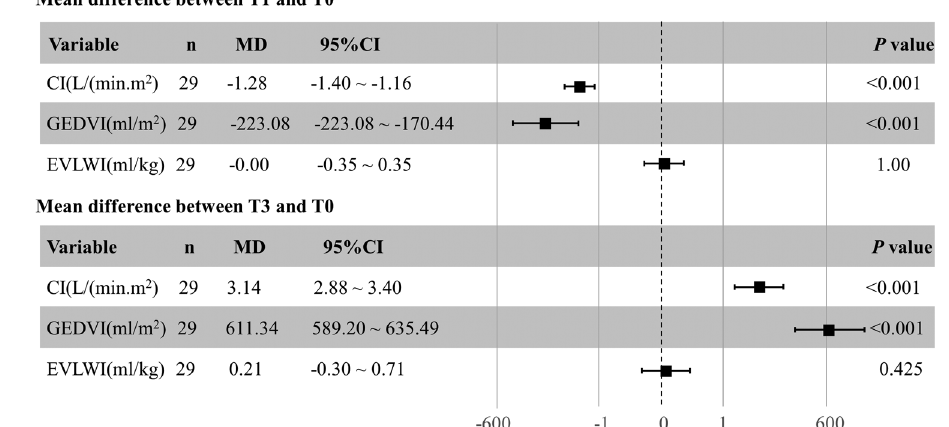
Figure 2: PICCO parameters changed at T1 and T3 when compared to baseline measurements ( T0 ) from 29 datasets obtained from 15 patients. MD: mean di ff erence; 95% CI: con fi dence interval; CI: cardiac index; GEDVI: global end - diastolic volume index; CRRT: continual renal replacement therapy; T0: before CRRT; T1: immediately after CRRT started; T3: immediately after CRRT